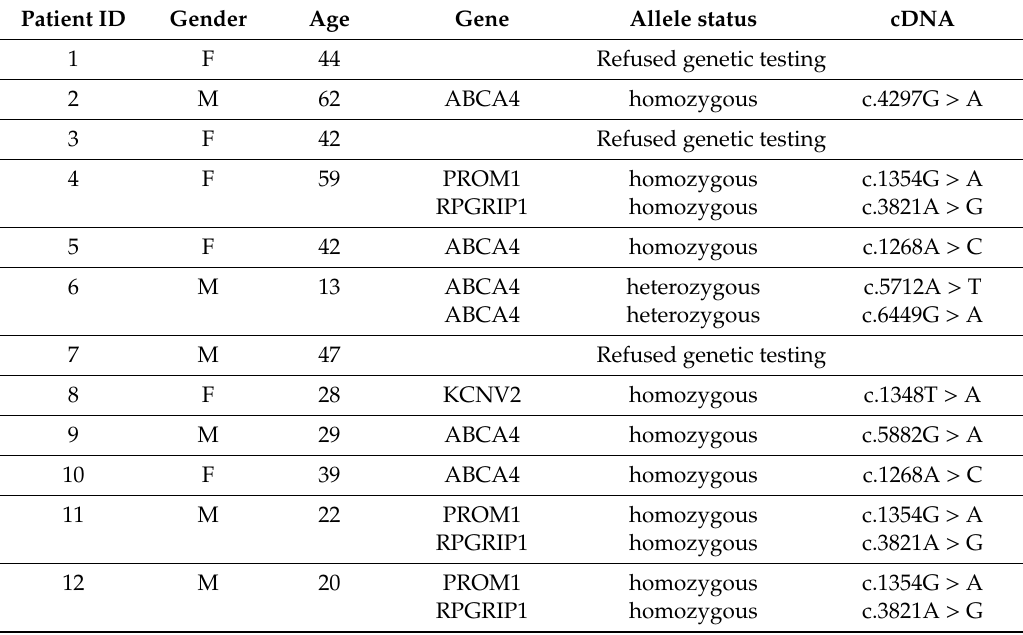
Table 1. Age, gender and genetic profile of patients with cone